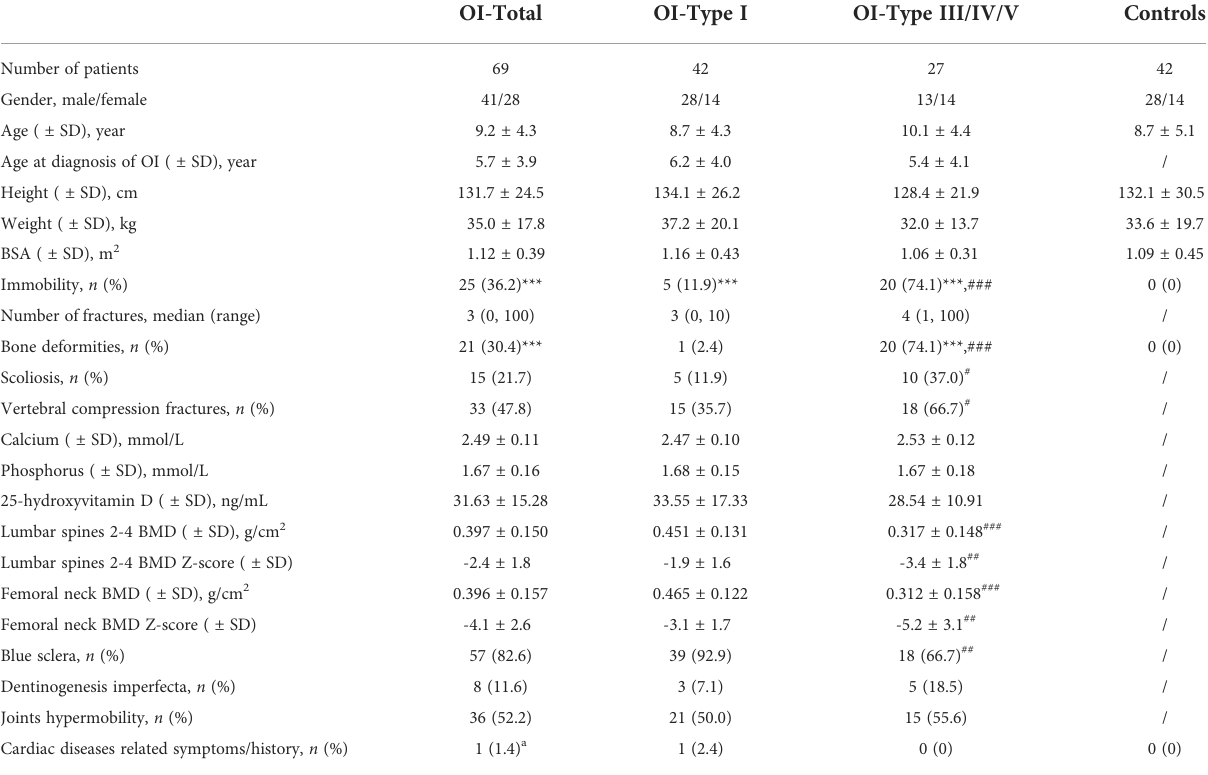
TABLE 1 Demographic data and baseline characteristics of OI patients and